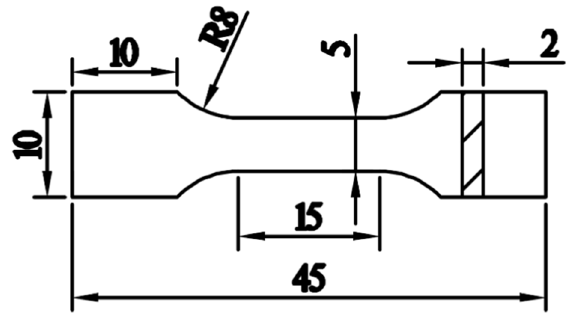
Figure 4. Sizes of tensile samples (unit mm).